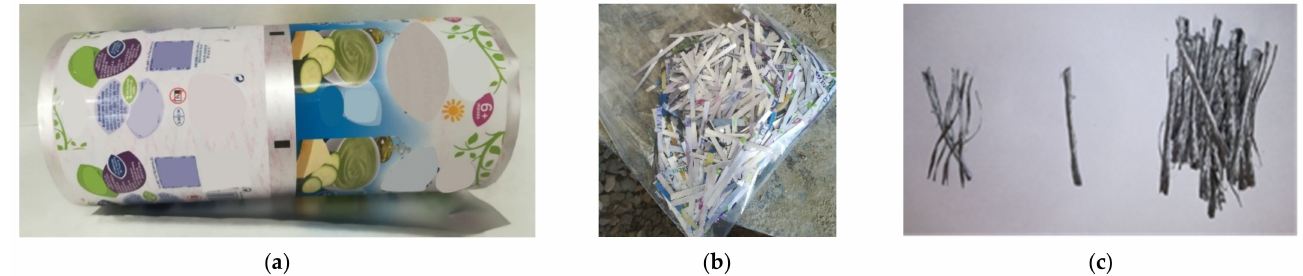
Figure 1. Plastic fibres: plastic waste rolls from food packaging ( a ); the prepared fibres ( b ); commercial polypropylene fibre ( c